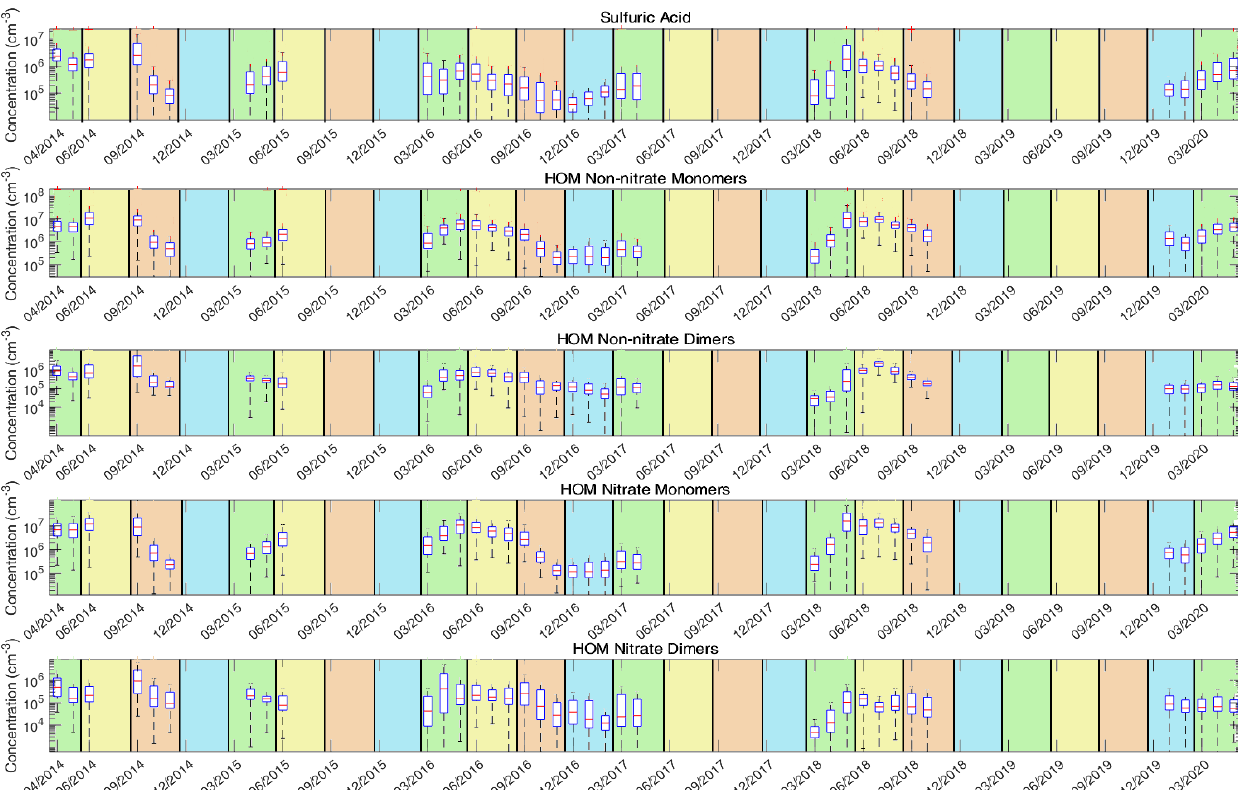
Figure 8. The time series of the selected atmospheric aerosol precursor vapors. From the top down, the time series are shown for sulfuric acid, HOM non-nitrate monomer, HOM non-nitrate dimer, HOM nitrate monomer, and HOM nitrate dimer concentrations, respectively. The time series are from April 2014 to April 2020. The red line is the median concentration for each month, and the blue box contains 75% of all data points. The whiskers mark the location of the 95th and 5th percentile data points. The areas with the green background are spring months, the yellow background represents summer months, the brown background represents autumn months, and the blue background represents winter